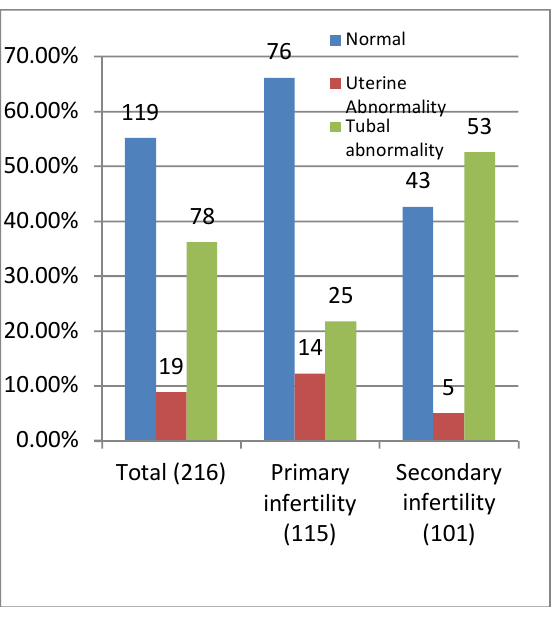
Figure 1 : Distribution of HSG findings